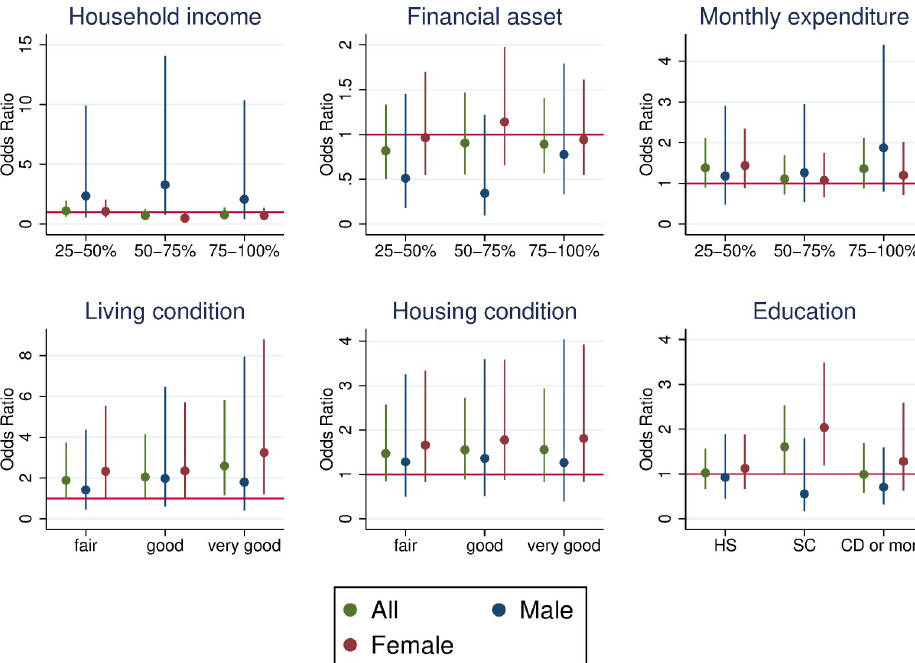
Fig 1. Odds ratio of care provision for parents by SES. The figure shows the odds ratio of care provision compared to the lowest SES category based on logistic regressions controlling for the age and age squared, gender (for all), marital status (married and not divorced or widowed = 1), and working status (working = 1) of the respondents. The bars represent the 95% confidence interval. The dependent variable is a binary variable that takes unity if a respondent provides care to any parent and zero if at least one parent is alive and the respondent does not provide care. Each panel shows a different SES measure. The sample of the analysis consisted of those whose parents were alive. The number of observations for all the respondents ranges from 1,708 (household income) to 3,536 (living and housing conditions).